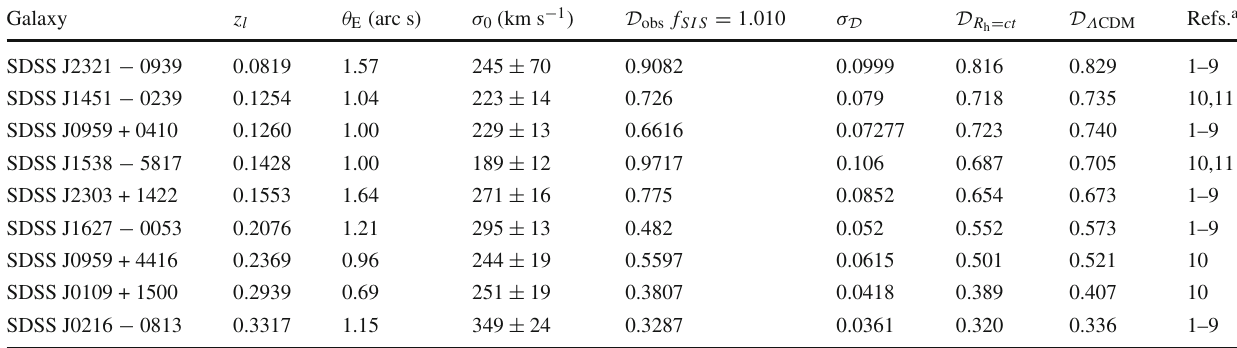
Table 4 Strong gravitational lensing systems with 0 . 51 < z s < 0 .